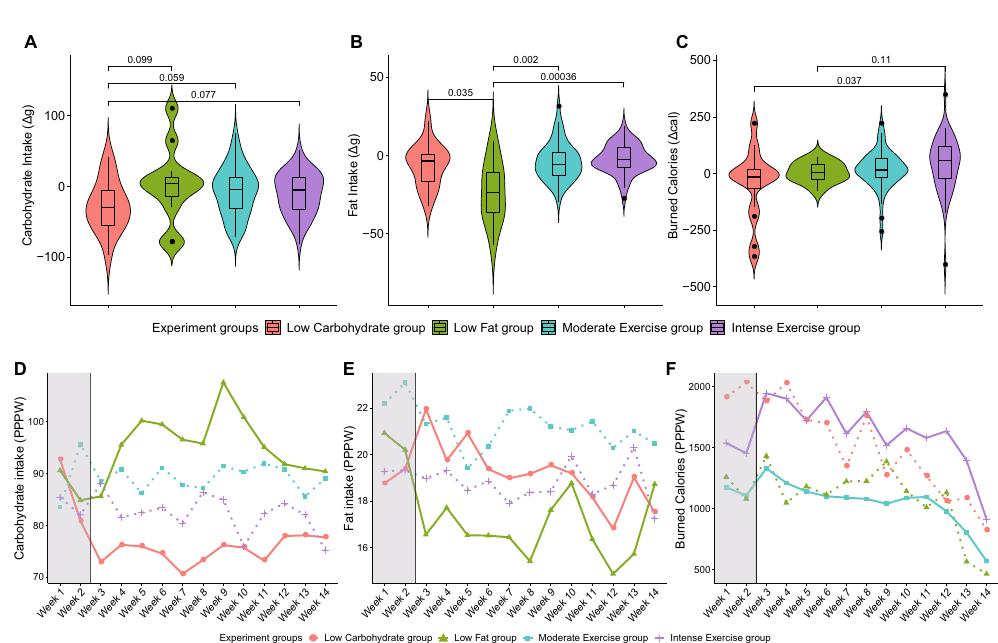
Figure 2. Comparison of caloric expense upon exercise and nutrient intake between the baseline and observation periods. ( A–C ) Differences in the nutrient intake and exercise between the baseline and observation period. ( A ) The differences in the carbohydrate intake (g) between the baseline and observation periods of each group were measured and compared with those of the low carbohydrate group. ( B ) The differences in fat intake (g) between the baseline and observation periods were measured and compared with those of the low-fat group. ( C ) The levels of exercise change between the baseline and observation periods were measured based on their mean caloric expense per day upon exercise. The burned calories per day of the nutrient modification groups were compared with those of the intense-exercise group. ( D–F ) Weekly caloric expense upon exercise and nutrient intake. The area shaded in gray represents the baseline period. ( D ) Mean carbohydrate intake per person per week (PPPW) values through lunch were measured in each group, the carbohydrate intake of the low carbohydrate group being constantly lower during the observation period compared to the other groups. The solid line and dashed line represent weekly caloric expense upon nutrient intake, and exercise, respectively. ( E ) Mean fat intake PPPW values through lunch were measured per each group, and the fat intake was reduced during the observation period in the low-fat group. The solid line and dashed line represent weekly caloric expense upon nutrient intake, and exercise, respectively. ( F ) Mean expanded caloric PPPW values were measured in each group. The intense exercise group shows an overall high caloric expense compared to the other groups. The solid line and dashed line represent weekly caloric expense upon exercise, and nutrient intake,